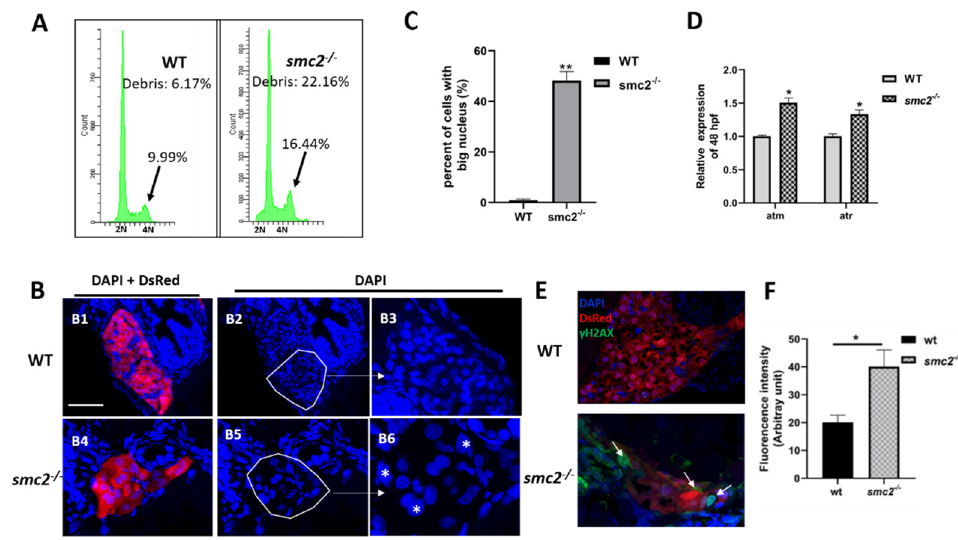
Figure 7 . Extensive apoptosis occurring in liver of SMC2 − / − mutants is attributable to DNA damage. ( A ) FACS analyses after DAPI staining of dissociated cells at 96 hpf from wild-type and SMC2 − / − embryos. The SMC2 − / − embryos have an accumulation of cells in the G2/M phase and more debris. ( B ) Frozen sections were stained with DAPI to visualize nuclei under the Tg (fabp10a:dsRed; ela3l:EGFP) transgenic background at 96 hpf. The SMC2 − / − embryos have an increased number of cells with bigger nucleus compared with WT. Fig. B3 and Fig. B6 are enlargement of the framed part in Fig. B2 and Fig. B5, respectively. *, bigger nuclei. ( C ) Quantitative analysis of the cell numbers with big nucleus in the liver. Three WT and three mutant embryos across the liver were determined using the ImageJ software. **, p < 0.01. ( D ) Expression levels of genes ( atm and atr ) implicated in DNA damage response pathway were analyzed by qPCR in WT and SMC2 − / − mutants at 96 hpf. Expression levels were normalized to WT embryos. Data expressed as mean ± SD were representative of three independent experiments. * p < 0.01. ( E ) Frozen sections were stained against γ -H2AX antibody, which marks DNA double-stranded breaks and nuclei counterstained with DAPI (blue) under the Tg (fabp10a:dsRed; ela3l:EGFP) transgenic background at 96 hpf. The signal was labeled with white arrowhead. ( F ) Quantitative analysis of the apoptotic cells in the liver. Fluorescence intensities of three WT and three SMC2 − / − mutant across the liver were determined using the ImageJ software. **, p < 0.01.